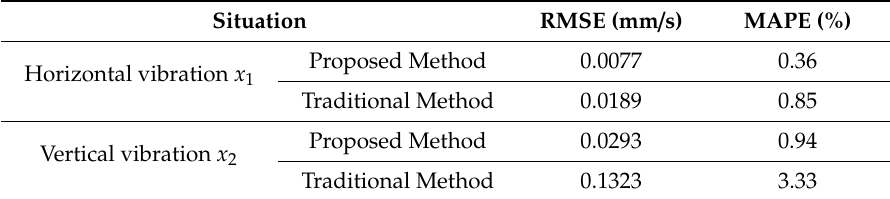
Table 5. Comparison of RMSE and MAPE for condition